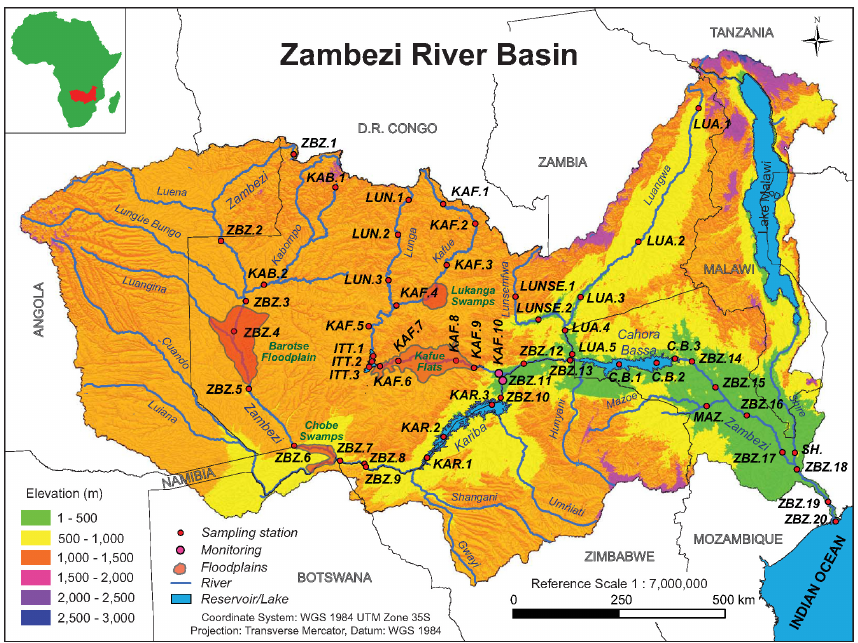
Figure 1. Map of the Zambezi River basin illustrating the location within Africa, the shared area of the basin within the eight African nations, the elevation gradient, the main hydrological network and the distribution of sampling sites along the Zambezi mainstem and major tributaries.